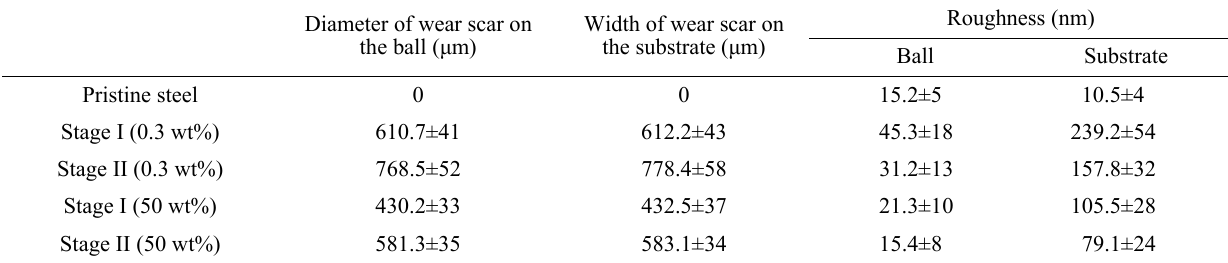
Table 2 Characterizations of the worn regions on the steel balls and substrates. The error represents a standard deviation.